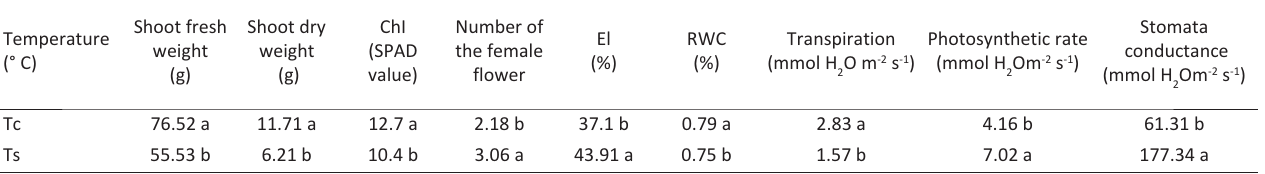
Tc= optimum temperature, Ts= low temperature.